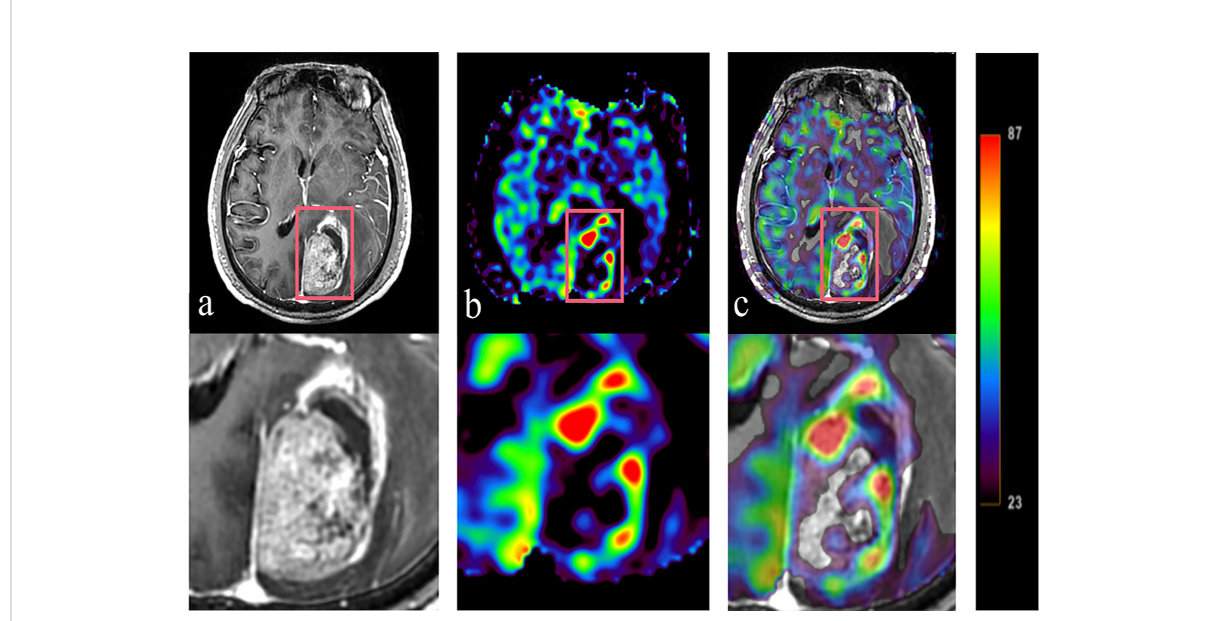
FIGURE 3 Tumor information is expressed T1WI+C and 3D-ASL images. A 61 year old BMs patient with primary colon carcinoma. According to the enhanced area shown in the T1WI+C images, 3D-ASL showed the uneven distribution of CBF in tumor. The hyperperfused subvolumes are mainly located on the left side of the enhanced edge, while the GTV H and the enhanced area overlap in a large region. Moreover, the fusion image c shows this result better. (A) T1WI+C images; (B) 3D-ASL images; (C) 3D-ASL images fuse with T1WI+C